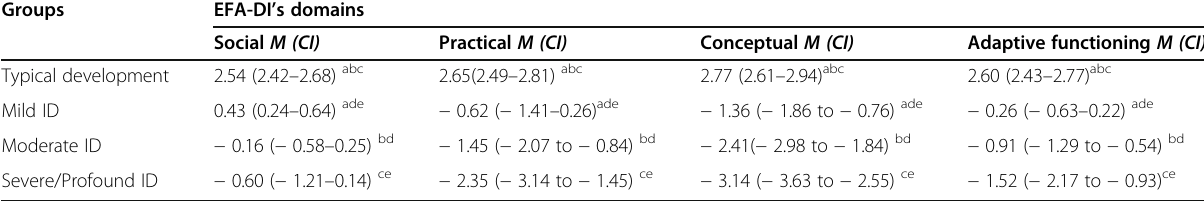
Means were adjusted for participants ’ sex and age. The superscript letters identify the means for adaptive functioning that differed significantly ( p < 0.05) from the type of diagnosis reported. Two equal letters in each column indicate that means are significantly different IC 95% bootstrap confidence